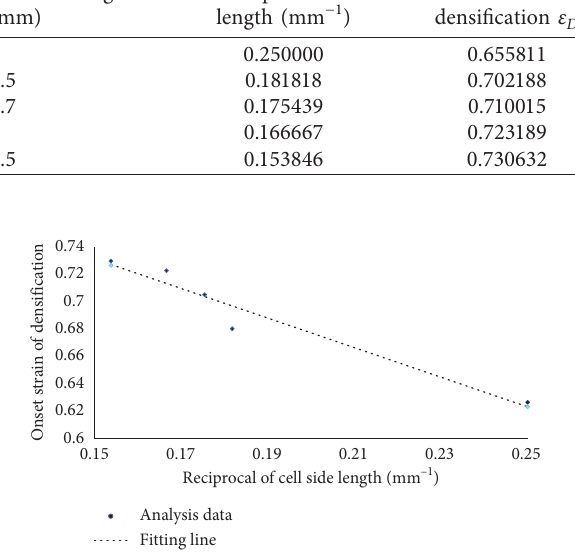
Figure 8: Influence curve of cell side length on the onset of